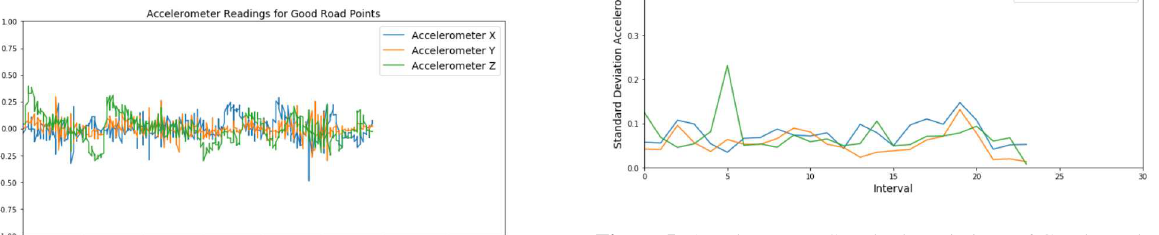
Figure 5. Accelerometer Standard Deviations of Good Road In-